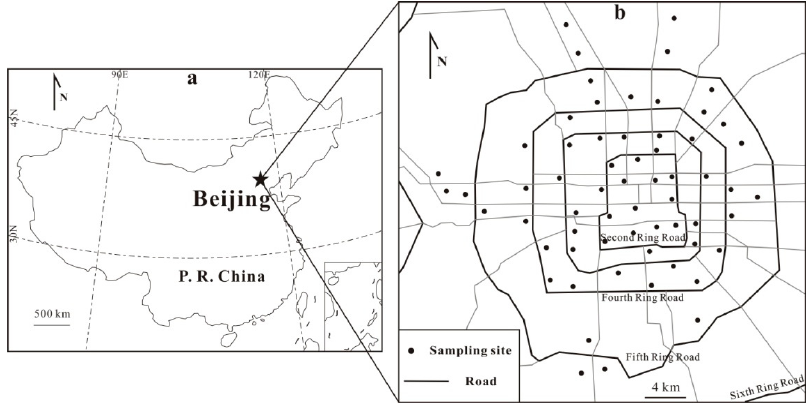
Figure 1. ( a ) Location of the Beijing City in China; and ( b ) the 62 sampling sites for settled dust in the Beijing urban area.